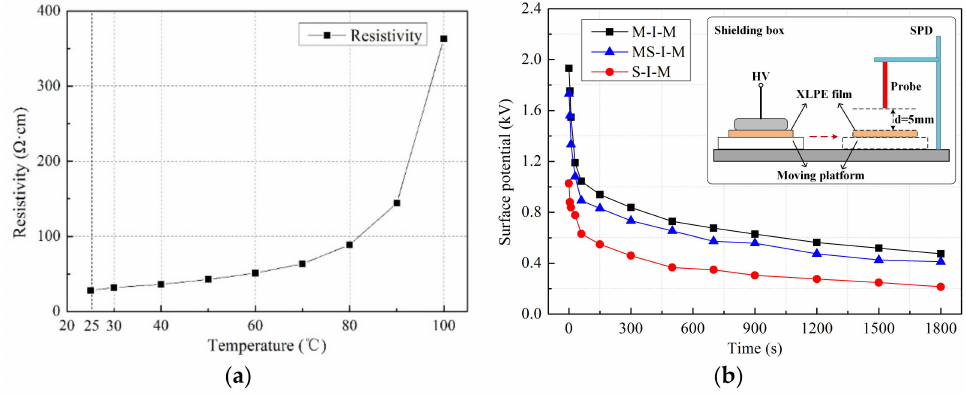
Figure 5. Test method and validation. ( a ) Changes of resistivity of semi-conductive composites with temperature; ( b ) surface potential decay over time of semi-conductive composites under di ff erent electrode